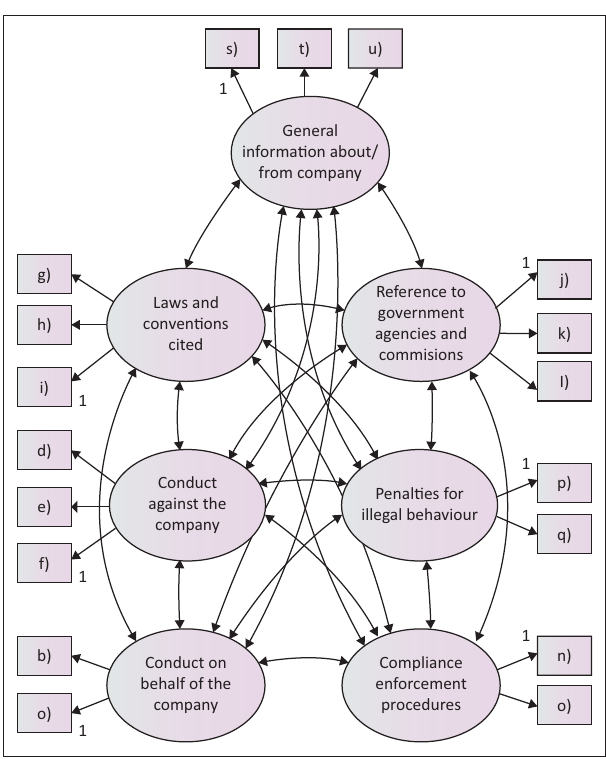
FIGURE 1: Code of ethics measurement model.